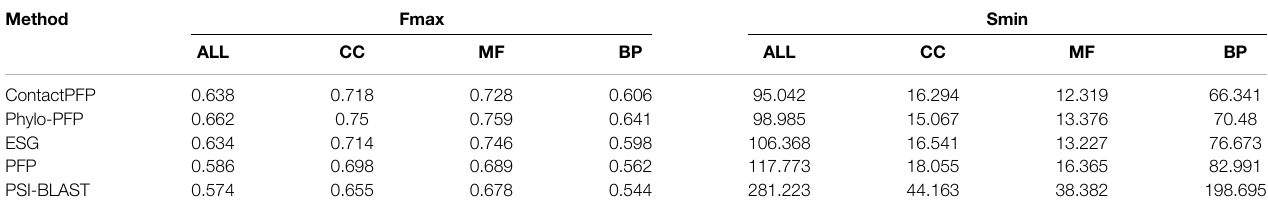
TABLE 2 | The average Fmax score and Smin score in the three GO categories. Method Fmax Smin ALL CC MF BP ALL CC MF BP